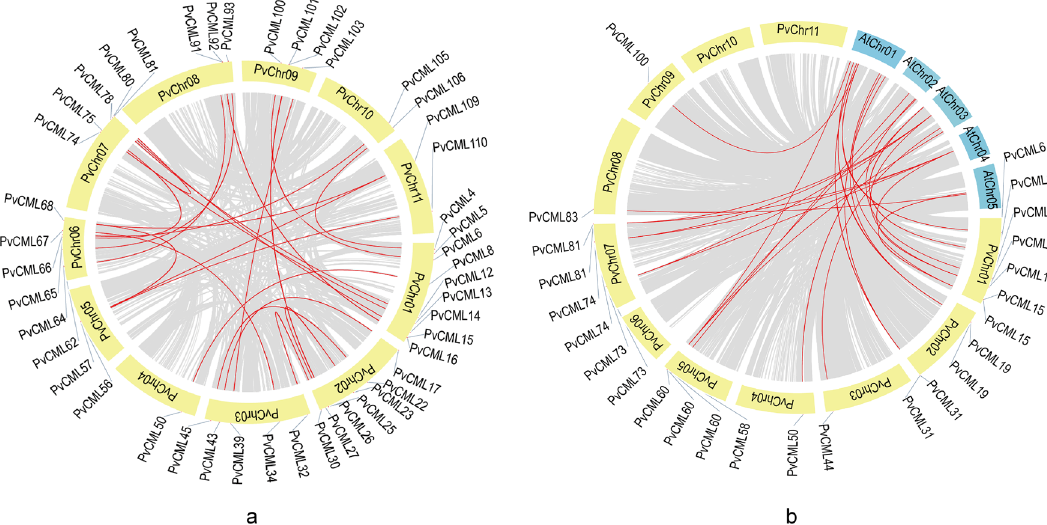
Figure 5. Duplication events of CML genes. The dispersed and segmental duplication events of PvCML genes in P. vulgaris ( a ) and the synteny relationships of PvCML genes between P. vulgaris and Arabidopsis ( b ). Red lines indicated segmental duplication of PvCML